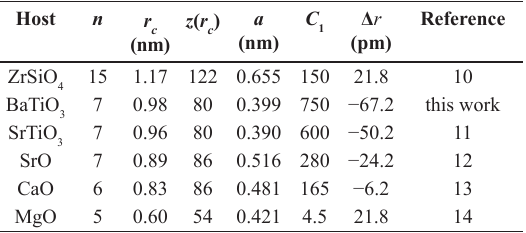
several host lattices.